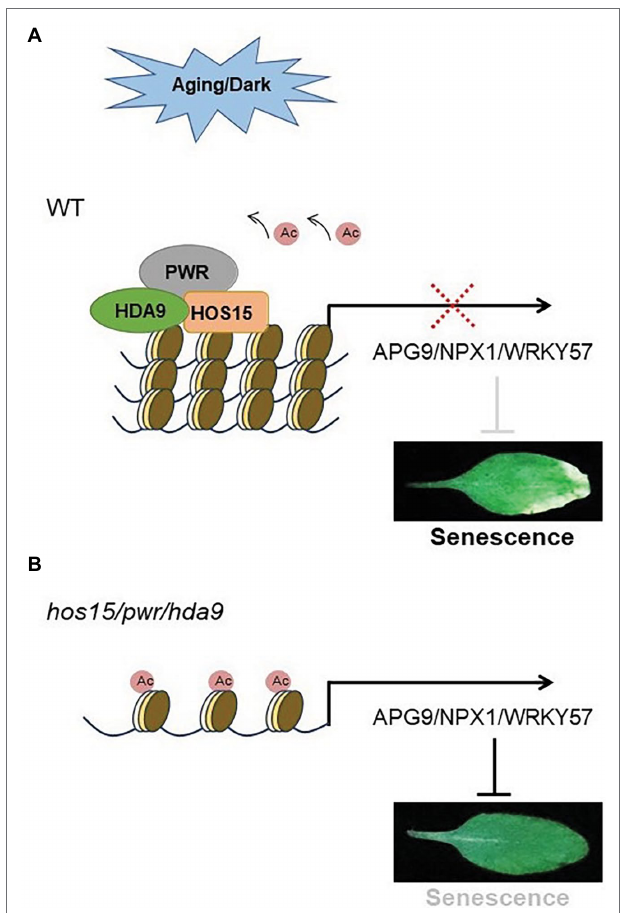
FIGURE 7 | Proposed model. (A) HOS15 works with HDA9/PWR in the same complex, which positively regulates plant senescence through developmental aging process and dark stress. In the developmental aging process or dark stress, the HOS15-PWR-HDA9 complex promotes senescence through the repression of the same target genes, such as NPX1, APG9 , and WRKY57 , which are the key negative regulators of plant senescence. (B) NPX1, APG9 , and WRKY57 are hyperacetylated in plants that lack the HOS15/PWR/HDA9 complex as a whole or any component of this complex. Hyperacetylation of NPX1, APG9, and WRKY57 leads to strong inhibition of age-dependent or dark-induced